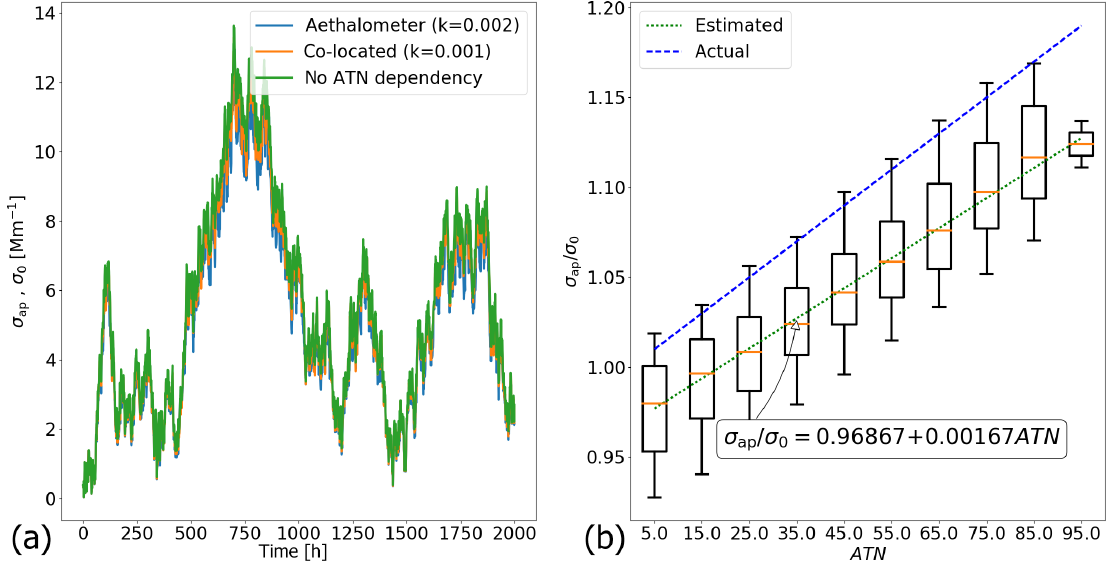
Figure B2. Same as Fig. B1 but with a variable concentration. Panel (a) shows the time series of a ATN-dependent σ 0 for a hypothetical Aethalometer and co-located PSAP so that the filter changes were not performed in synchronization. The “No ATN dependency” in the figure legend denotes σ ap in Eq. (B1), from which both the hypothetical instrument ATN dependencies were calculated. Panel (b) shows the ATN dependence of the Aethalometer when compared to the ATN-dependent co-located